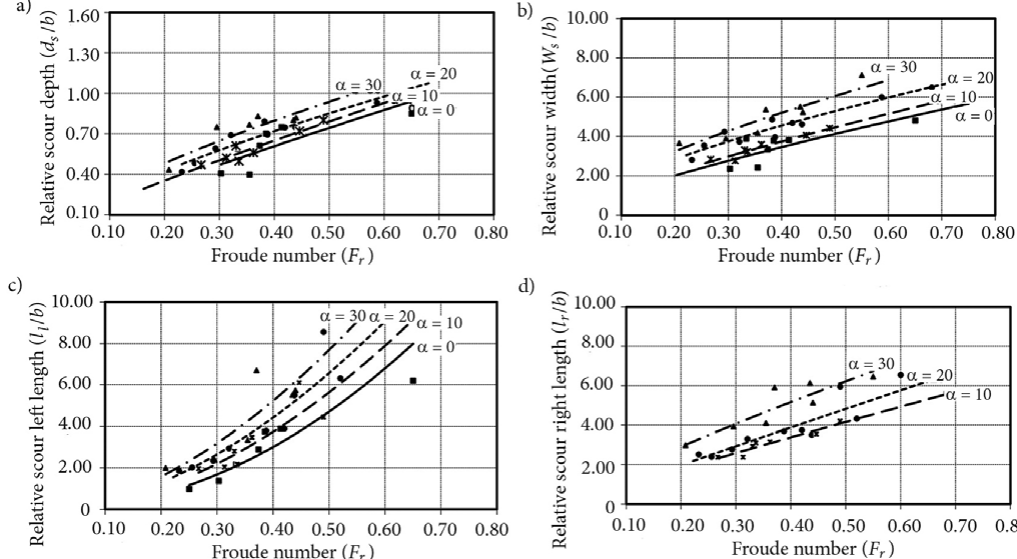
Figure 9. Froude number against relative scour depth, width, left side length and right side length with the varying skew